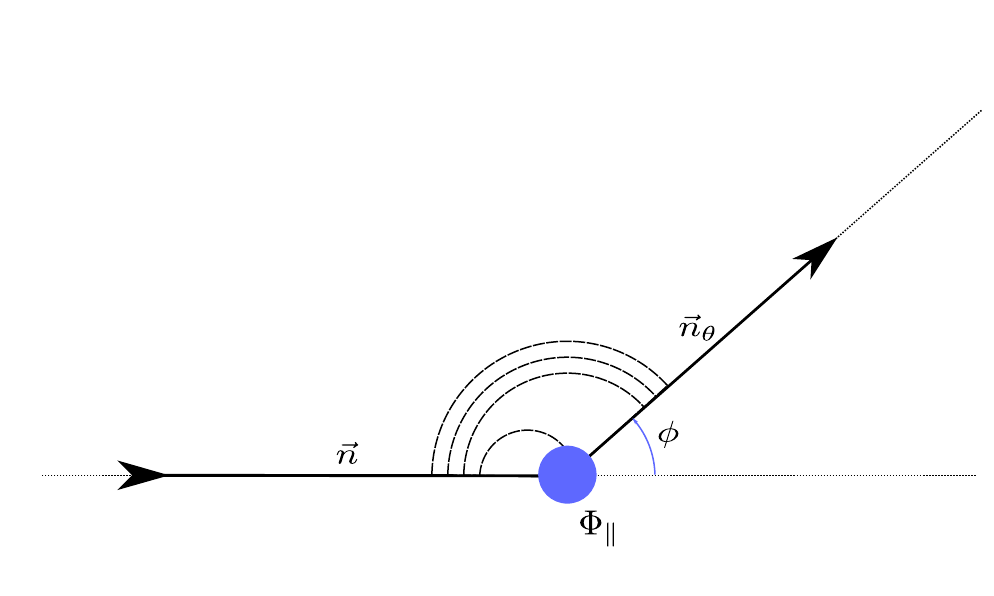
Figure 3 . Ladders limit: dashed lines represent scalar propagators. Each scalar propagator joining two Wilson rays contains a factor of g 2 cos (cid:18) . The blue dot is a scalar insertion of (cid:8)